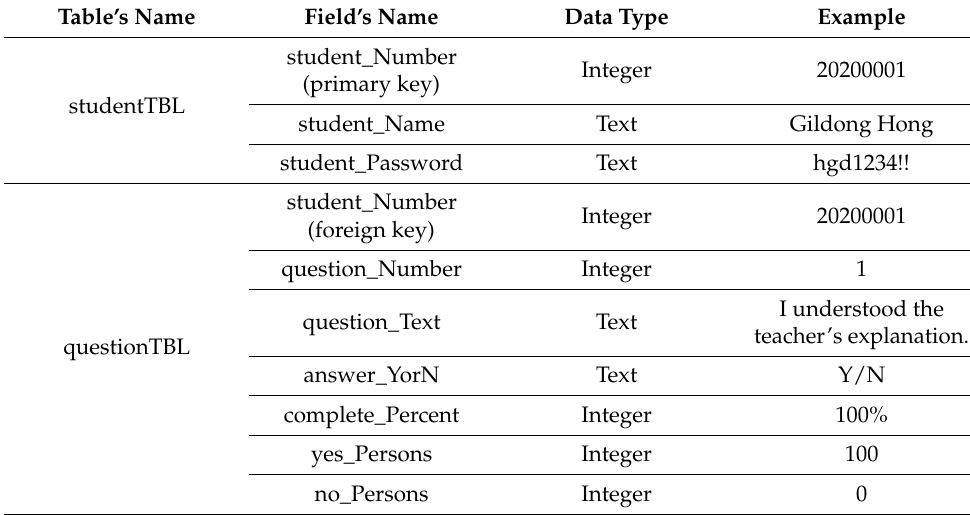
Table 3. Definition of tables and fields in database.